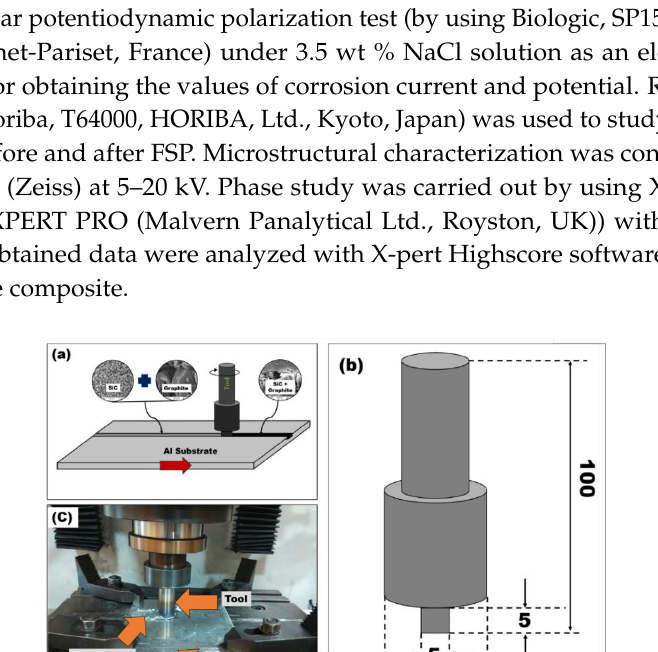
Figure 1. Scanning electron microscopy (SEM) micrographs of as-received ( a ) Al6061, ( b ) SiC powder, and ( c ) graphite powder.